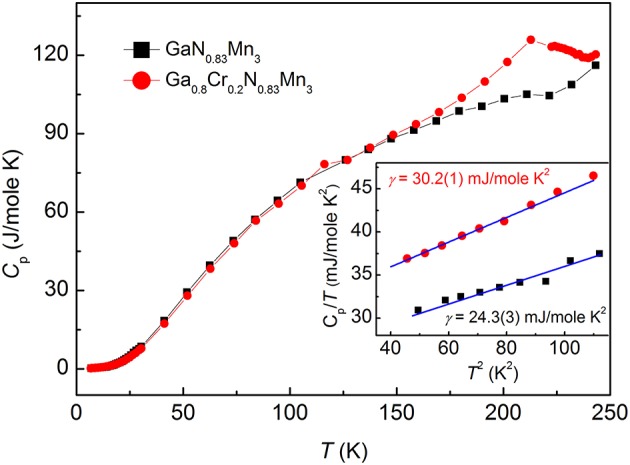
Specific heat Cp(T) for Ga1−xCrxN0.83Mn3 with x = 0 and 0.2. Inset shows a linear fit to the Cp(T)/T vs. T2 curves at low temperatures. The fitted electronic coefficients of specific heat (γ, the Sommerfeld constant) are shown for both compounds.